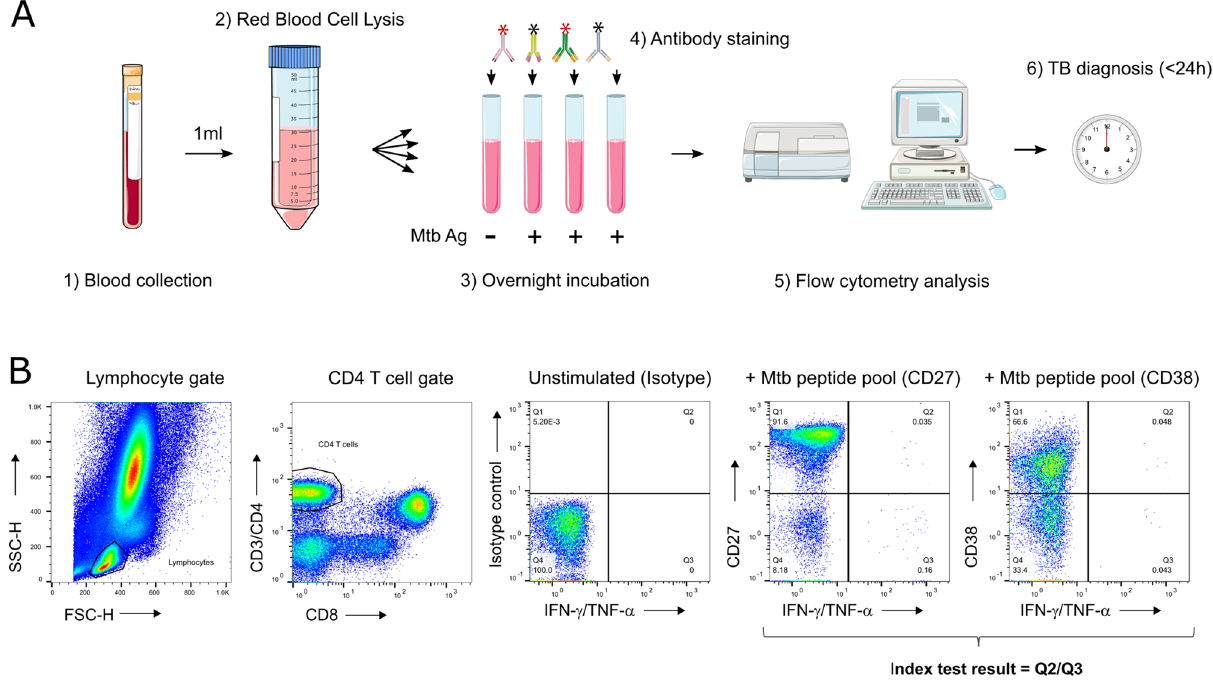
Figure 2. ( A ) TAM-based assay procedure overview from blood collection to delivery of results within 24 h. Briefly, a single millilitre of fresh blood was subjected to red blood cell lysis (steps 1 & 2) and white blood cells evenly split between 4 tubes before overnight stimulation (step 3). The following morning, cells were fixed and stained with fluorescent antibodies as detailed in the methods section (step 4). Samples were immediately acquired on a FACSCalibur delivering final results within 24 h following phlebotomy (steps 5 & 6). This figure was created using objects from Servier Medical Art, free to share and adapt, licensed under a Creative Commons Attribution 3.0 Unported License (CC BY 3.0) (http:// smart. servi er. com/). ( B ) Representative gating strategy of the TAM-based assay adapted for a 2-laser flow cytometer FACSCalibur apparatus. First, a gate